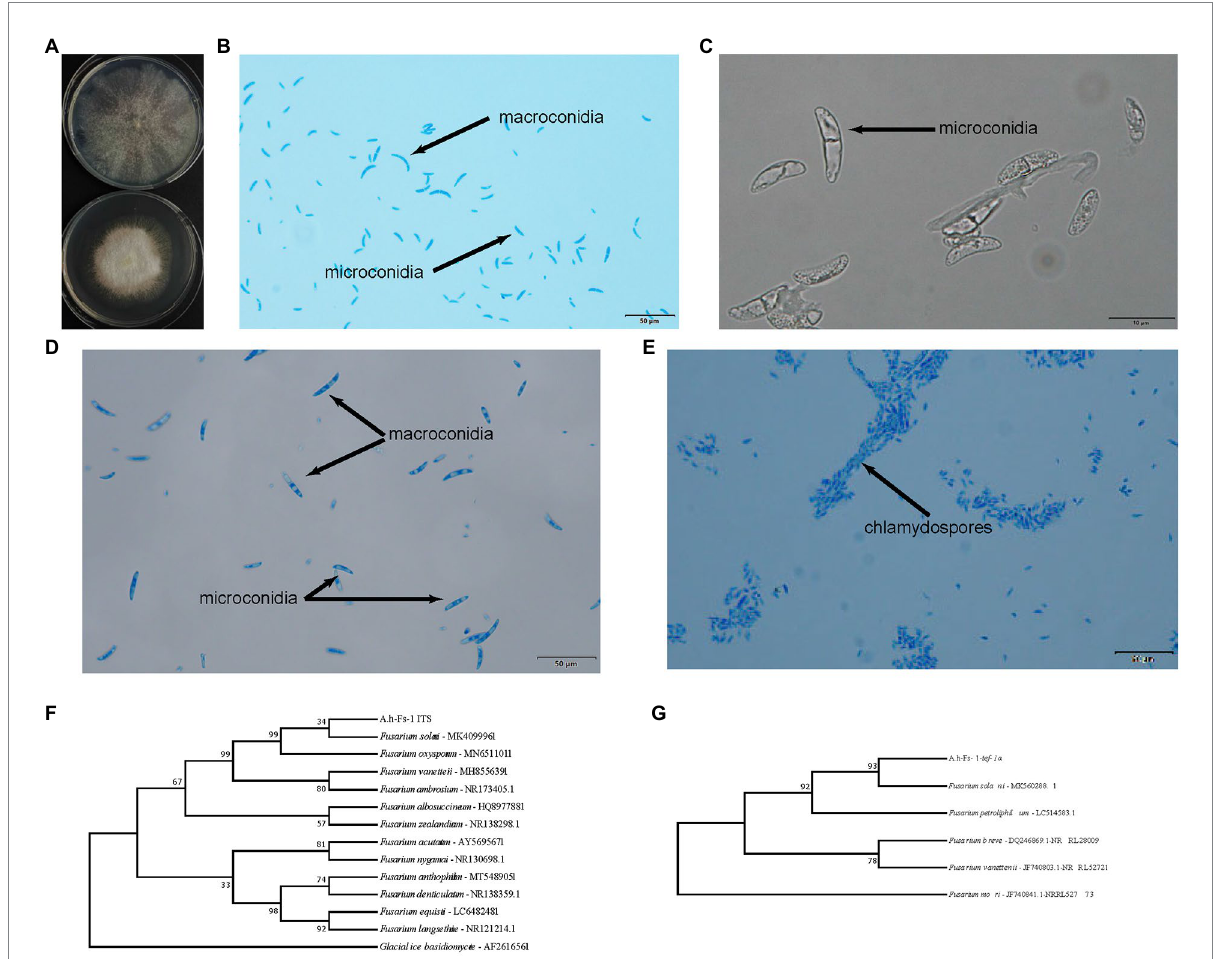
FIGURE 5 Identification of A.h-Fs-1 ( Neocosmospora solani ). (A) A.h-Fs-1 cultured on plate medium (top: A.h-Fs-1 on the AAI-coated inorganic salt medium plate; bottom: A.h-Fs-1 on PDA medium plate). (B) The microconidia and macroconidia of A.h-Fs-1 cultured on the AAI-coated inorganic salt medium plate. (C) The microconidia of A.h-Fs-1 cultured on the AAI-coated inorganic salt medium plate. (D) The microconidia and macroconidia of A.h-Fs-1 cultured on PDA medium plate. (E) Chlamydospores and hyphae of A.h-Fs-1. (F) ITS phylogenetic tree of A.h-Fs-1; (G) The tef-1 α phylogenetic tree of